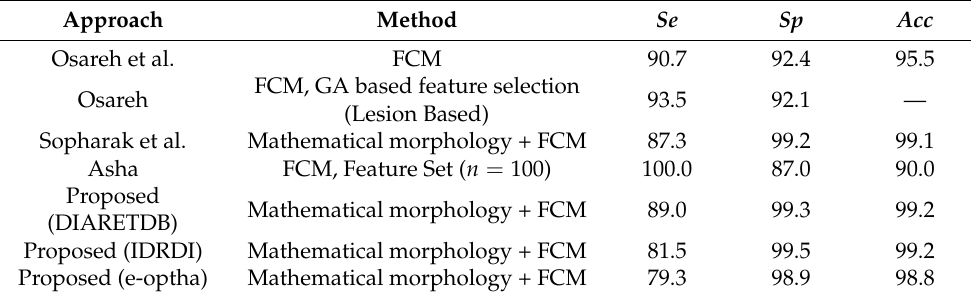
Table 3. A comparative study of FCM algorithms to detect